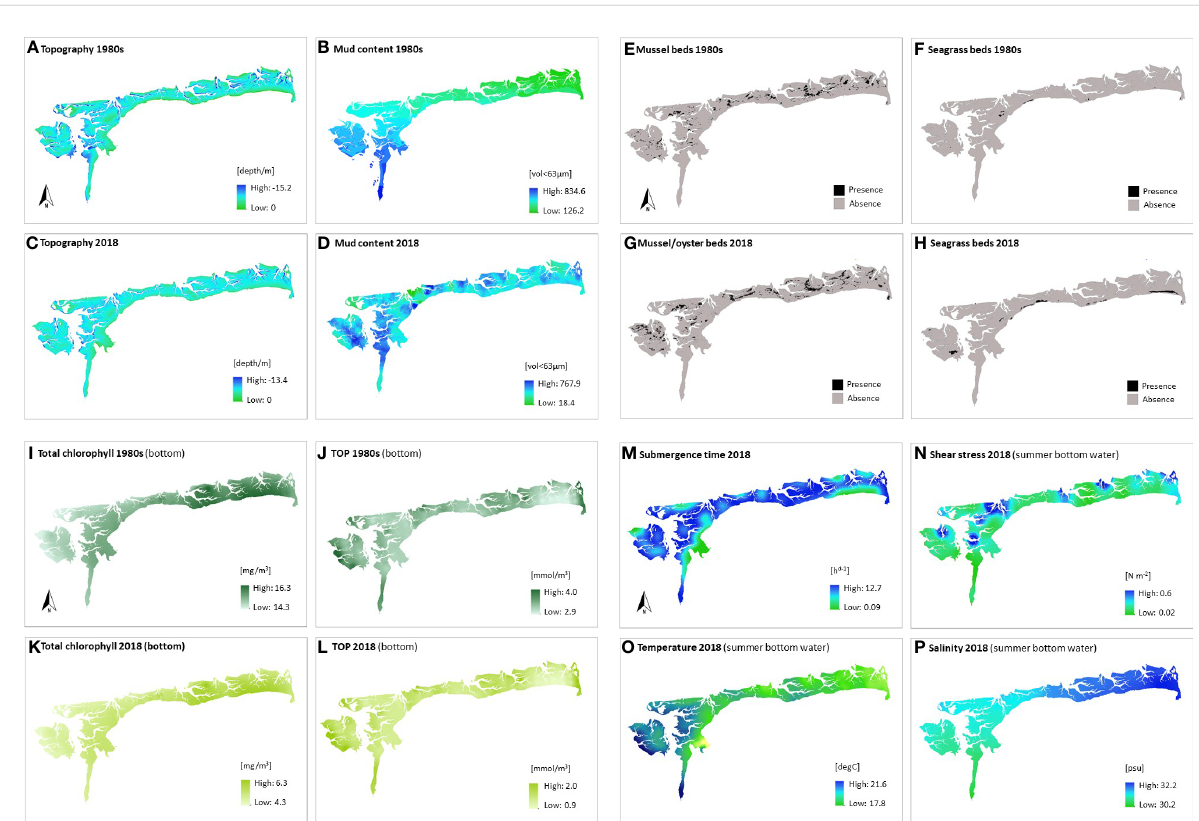
FIGURE 3 Environmental conditions in the EFWS (1980s versus 2018): (A) topography 1980s, (B) mud content 1980s, (C) topography 2018, (D) mud content 2018, (E) mussel beds 1980s, (F) seagrass beds 1980s, (G) mussel beds 2018, (H) seagrass beds 2018, (I) T_Chlb 1980s (hindcasted), (J) TOPb 1980s (hindcasted), (K) T_Chlb 2018, (L) TOPb 2018, (M) submergence time, (N) shear stress (summer bottom water), (O) temperature (summer bottom water) and (P) salinity (summer bottom water); converted in ArcGIS 10.7.1 to have the same extent (855.9 km2),